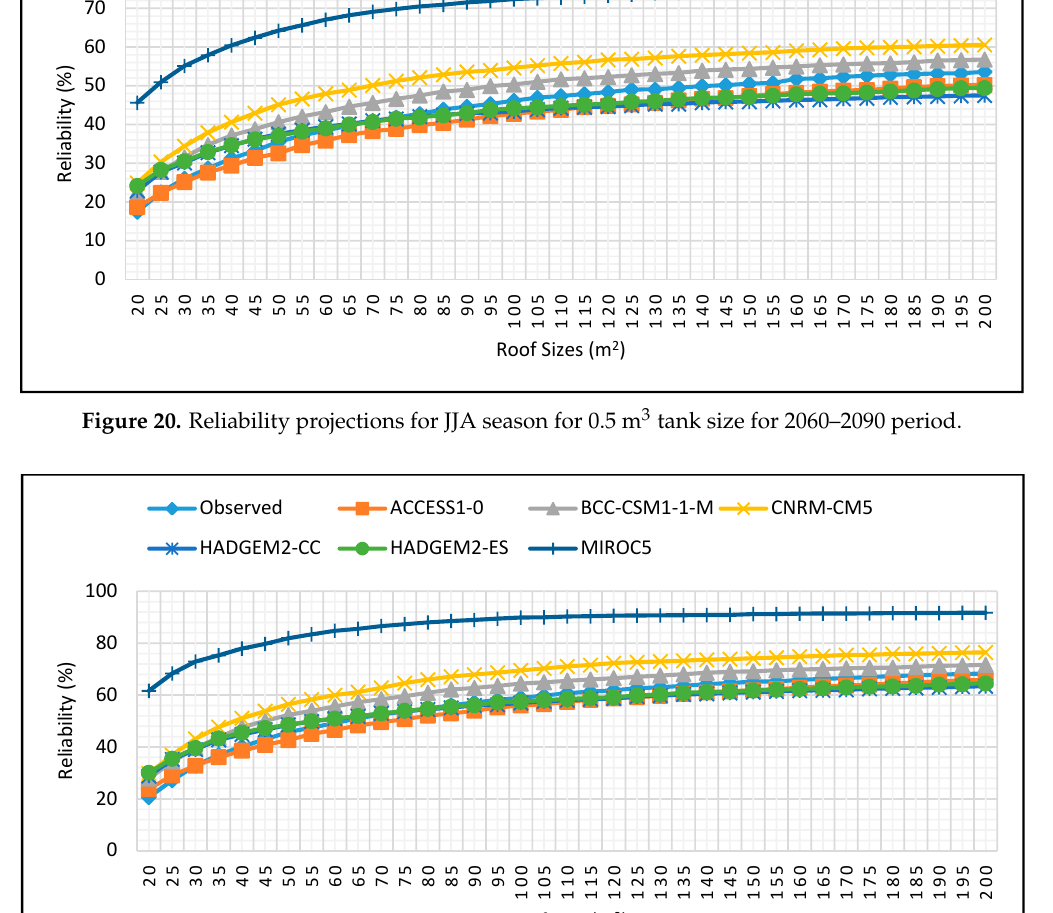
Figure 22. Reliability projections for JJA season for 2 m 3 tank size for 2060–2090 period. According to Figure 23, with a tank size of 5 m 3 , MIROC5 predicts that close to 100% reliability can be achieved at roof sizes as small as 30 m 2 while other models and the observed scenario attain over 80% reliability at roof sizes ranging from 55–120 m 2 . Increasing the tank volume to 10 m 3 does not show significant changes in reliabilities for all models. In addition, model predictions converge as tank and roof size increase. Comparing increase in reliability with increasing tank volume reveals that when tank volume is increased from 0.5 to 1 m 3 , reliability increases by 8–15% for all roof sizes and different models. The peak increase is obtained from roof sizes ranging from 50–100 m 2 while for MIROC5, the peak reliability increase is obtained at only 20 m 2 . Increasing tank volume from 0.5 to 2 m 3 increases reliability by 12–25% for all roof sizes and model but the highest increase is still obtained between 50 and 100 m 2 . When the volume is further increased to 5 m 3 , reliability increases by 14–35% with roof size of 50–100 m 2 yielding the highest increase except for MIROC5 which peaks at 20 m 2 . Increasing the tank volume beyond 5 m 3 , only marginally increases reliability but roof size requirement is reduced to 45–85 m 2 for all other models except MIROC5 which peaks at very small roof sizes.